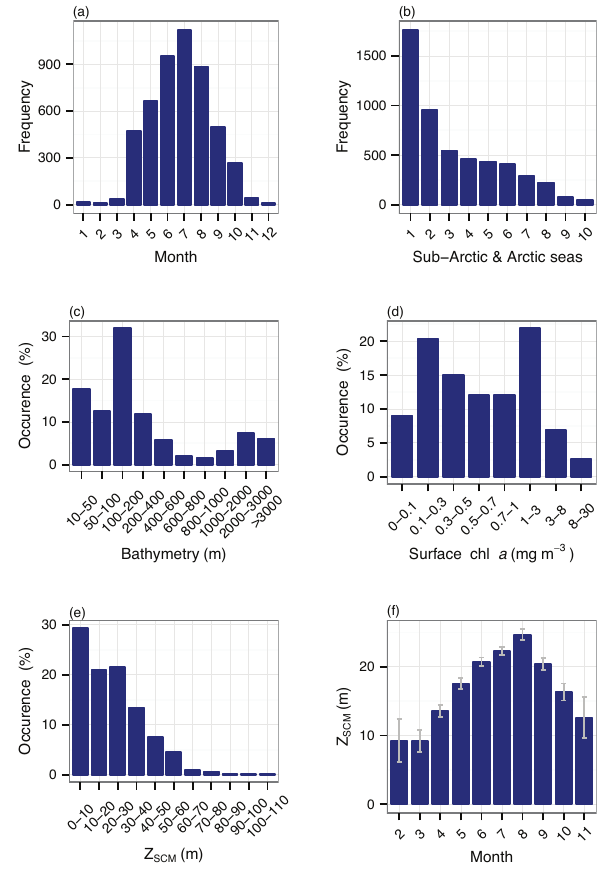
Fig. 2. Frequency distributions of number of sampled stations as a function of (a) month of the year, and (b) sub-Arctic and Arctic seas labeled in the Table 2; occurrence of sampled stations as a function of (c) bathymetry, (d) surface chlorophyll a (Chl a surf ) concentra- tion, and (e) Z SCM depth; (f) monthly variation of average Z SCM . In (f) , errors bars represent standard